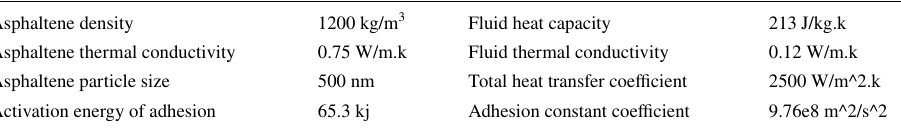
Table 10 Input parameters of asphaltene deposition